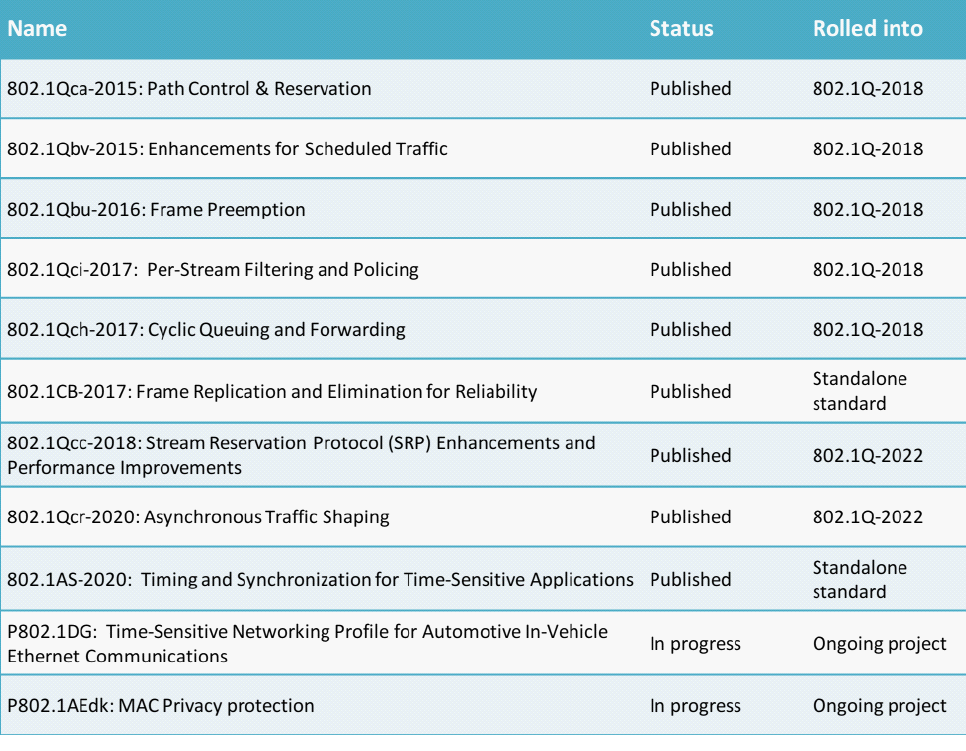
Figure 2. Main TSN standards relevant for in-car